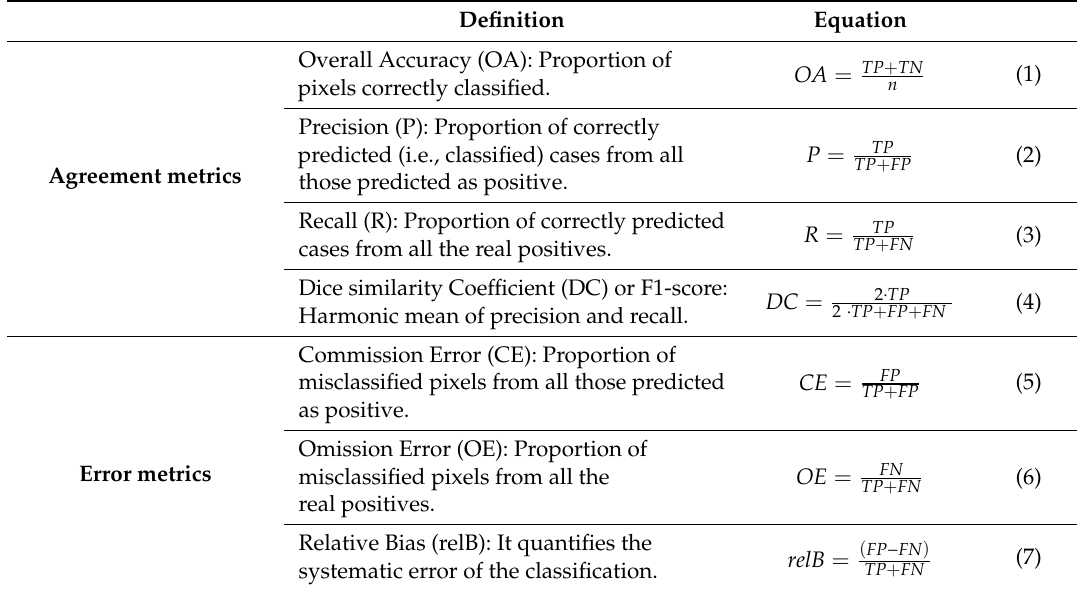
Table 4. Confusion matrix-derived agreement and errors metrics.